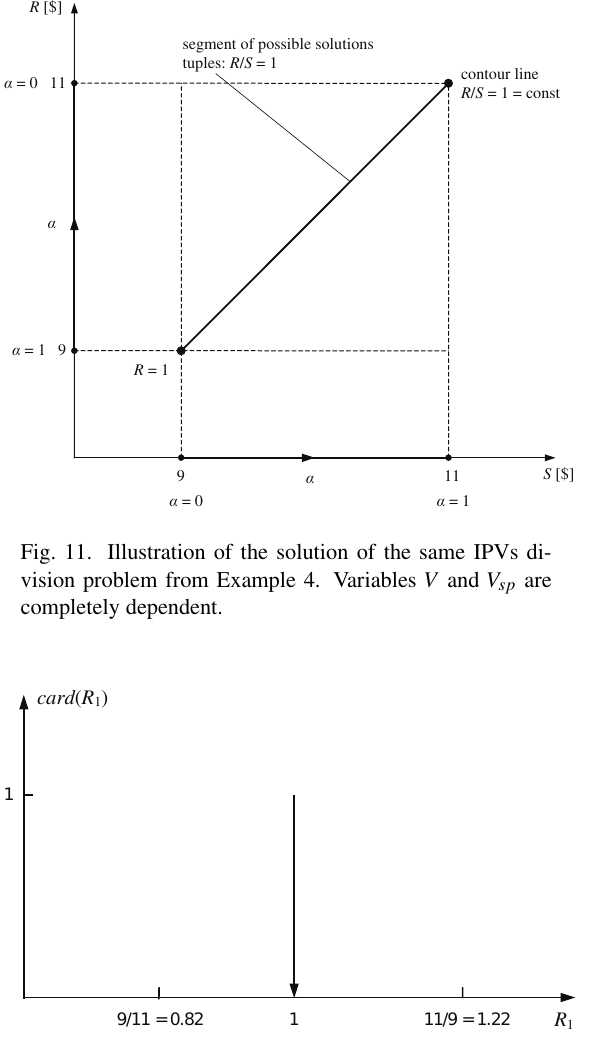
Fig. 12. The cardinality distribution card ( R 1 ) of the result of the same IPVs division obtained in Example